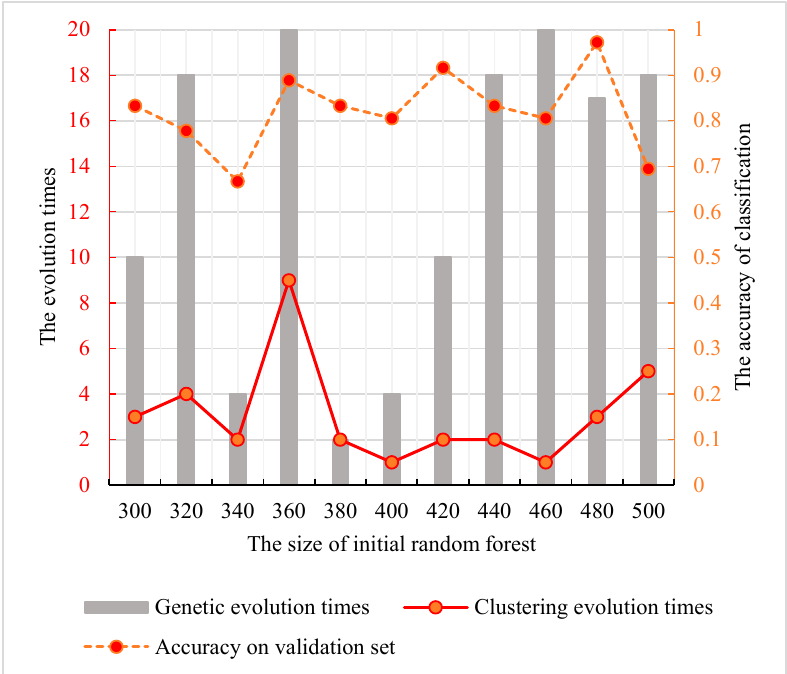
Figure 5. The relationship among the clustering evolution times, the genetic evolution times and the size of initial random forest in genetic clustering random forest. The dotted line indicates the accuracy of classification. The solid lines and bars indicate the number of genetic evolution times and clustering evolution times according to the initial random forest size.